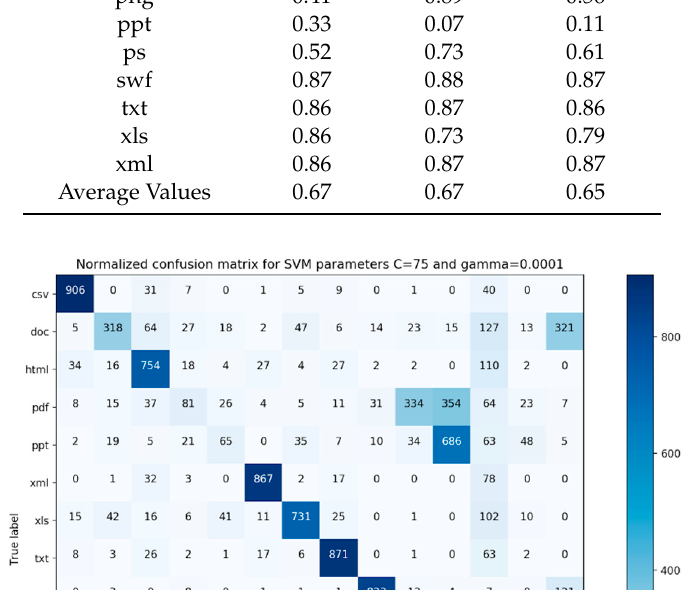
Table 4. Classifier results for hierarchy 1.